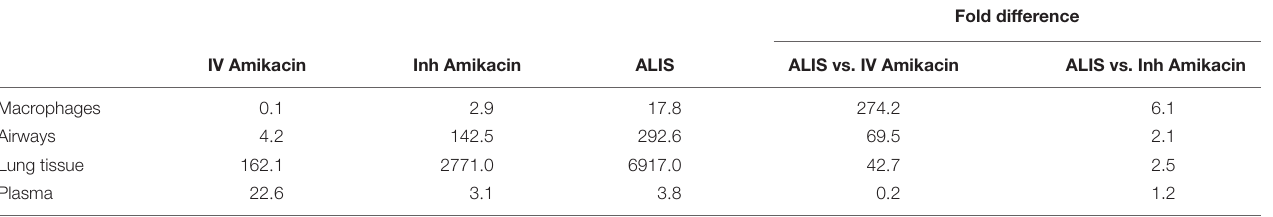
Fold difference